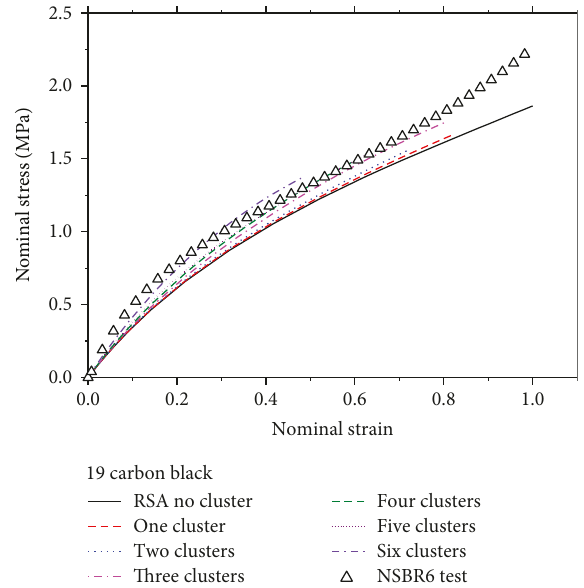
Figure 15: Stress-strain curves of NSBR6 with di ff erent numbers of clusters (same particle